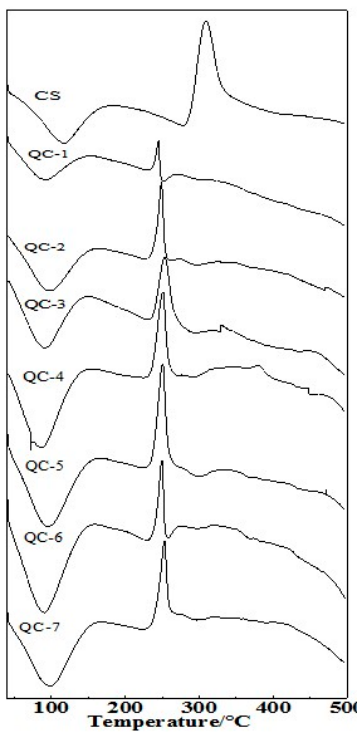
Figure 4. DSC thermograms of chitosan and QCs. Table 2. Peak temperature in DSC during the thermal degradation and water evaporation of chitosan (CS), quaternized chitosan (QCs). (The line break of Table 2 stands for the “endothermic” and “exothermic”, seperately).